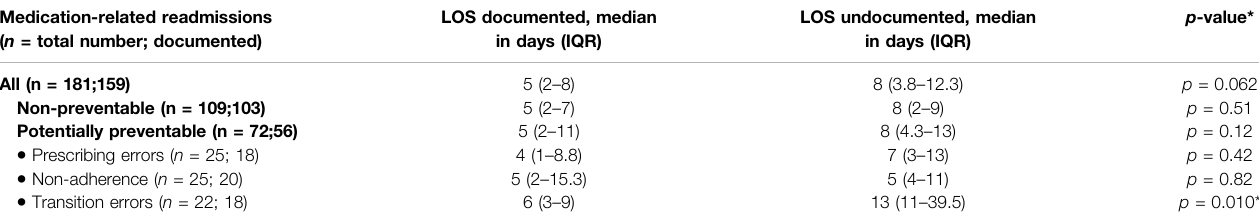
TABLE 3 | Differences in length of stay (LOS) between potentially preventable and non-preventable medication-related readmissions documented and those not documented during readmission. Medication-related readmissions ( n = total number; documented)